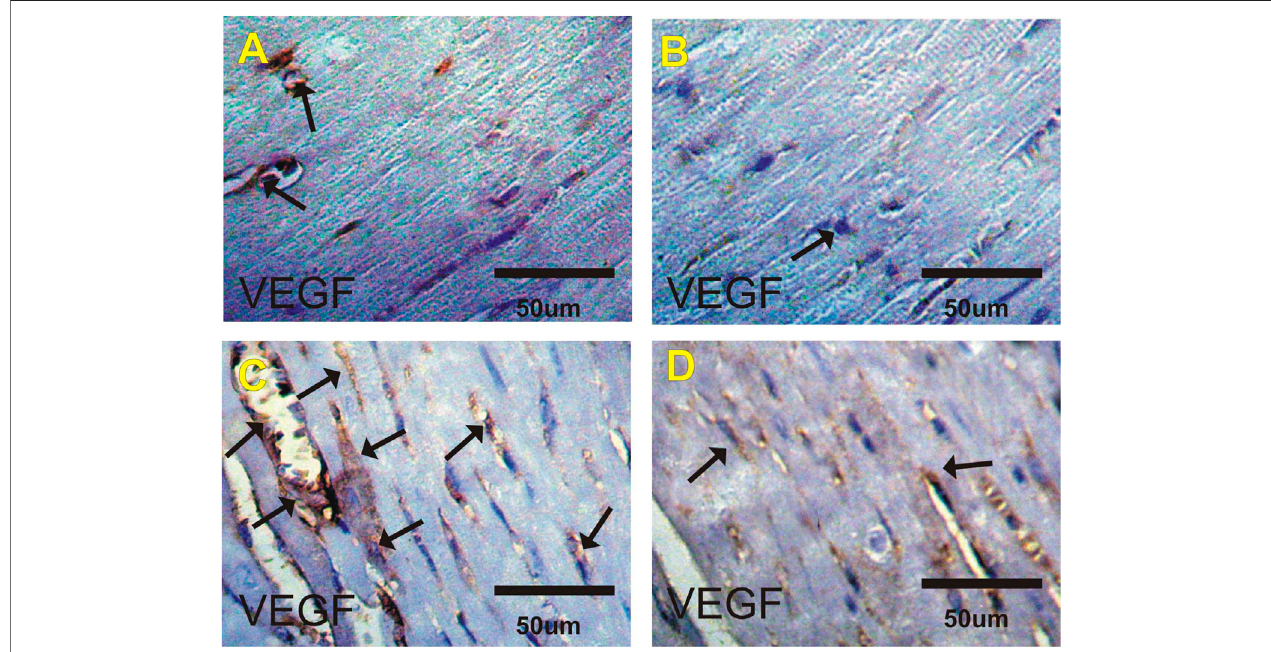
FIGURE4| PhotomicrographsofheartsectionsfromthedifferentexperimentalgroupsstainedwithVEGF-ir.FaintpositivereactionsforVEGFexpressioninthe (A) control and (B) costus groups. (C) EST group shows moderate to severe positive reactions (arrows) for VEGF expression. (D) EST group treated with costus shows moderate reactions (arrows) for VEGF expression. VEGF-ir, vascular endothelial growth factor immunoreactivity; EST, Ehrlich solid tumor.